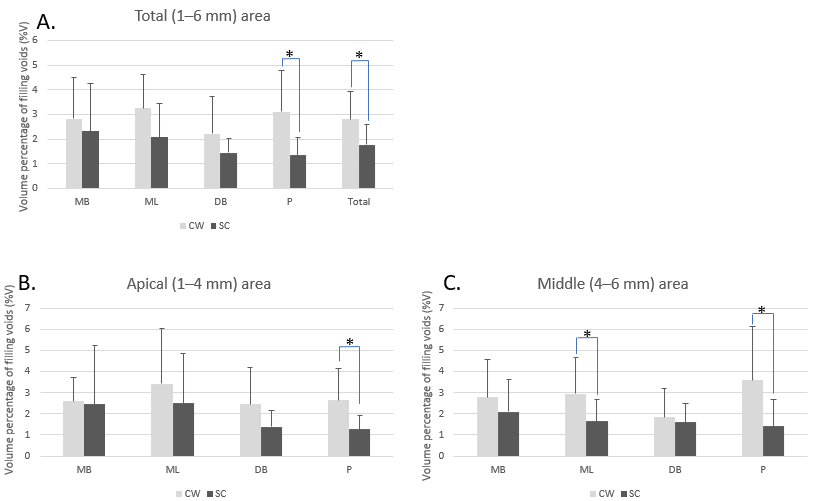
Figure 3. Bar graph of the volume percentage of canal filling voids. An independent two-sample t-test was performed to compare the void volume percent of the two different canal filling groups. ( A ) In the total area (1–6 mm from the apical tip), there is a statistically significant difference of the percentage of voids (%V) between CW (continuous wave filling group) and SC (single cone filling group) in P canal (palatal canals) and total canals. SC group showed less void volume percentage. ( B ) In the apical area (1–4 mm from the apical tip), the percentage of voids (%V) is significantly lower in the SC group in the P canal. ( C ) In the middle area (4–6 mm from the apical tip), the percentage of voids (%V) is significantly lower in the SC group in the MB2 (the second mesiobuccal canal) and P canals. Asterisks (*) indicate statistical significance ( p -value <